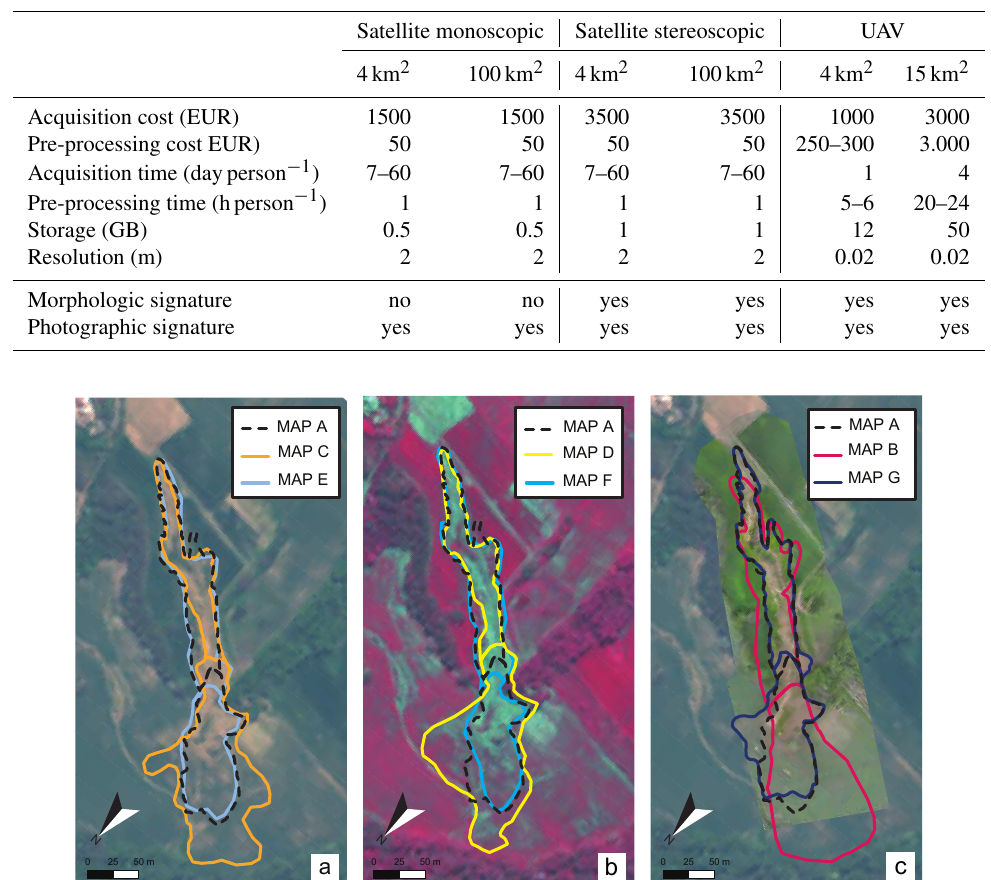
Table 3. Comparison of the estimated cost, acquisition and pre-processing time, and storage requirement for an area of 4km 2 (2km × 2km) and for an area of 100km 2 (10km × 10km), for monoscopic and stereoscopic satellite images, and for an area of 15km 2 for photographic images captured by a UAV.